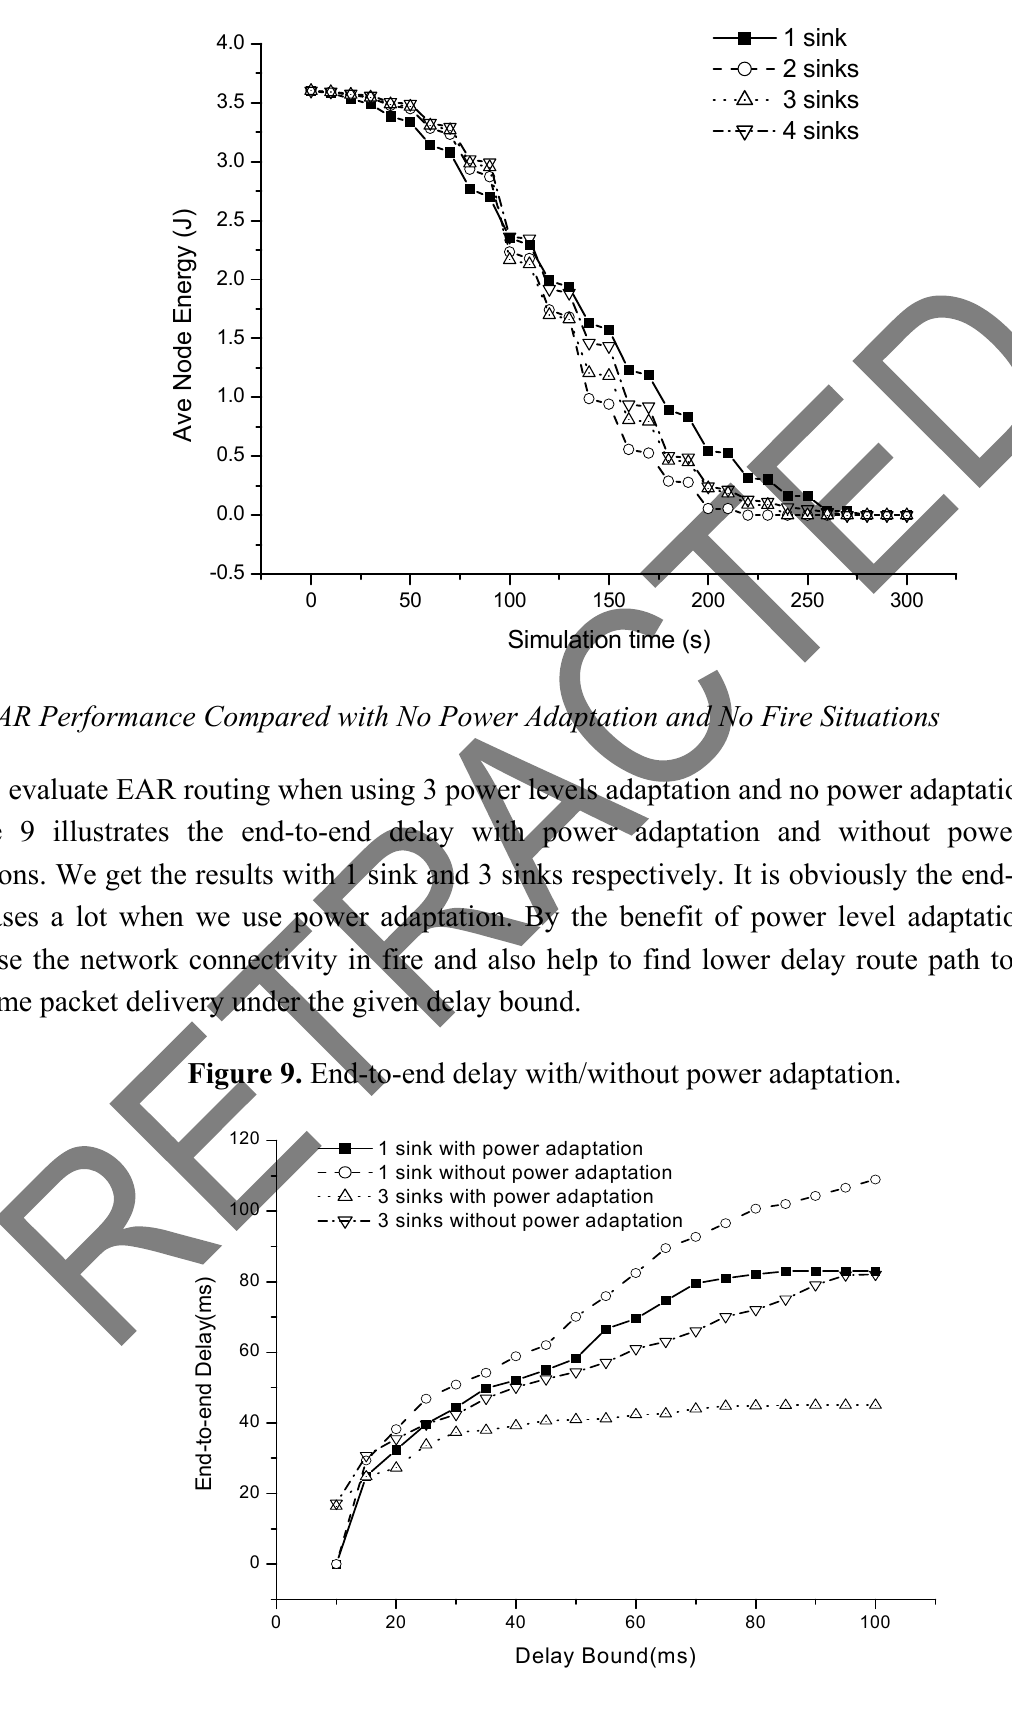
Figure 8. Average node energy when delay bound = 70 ms.